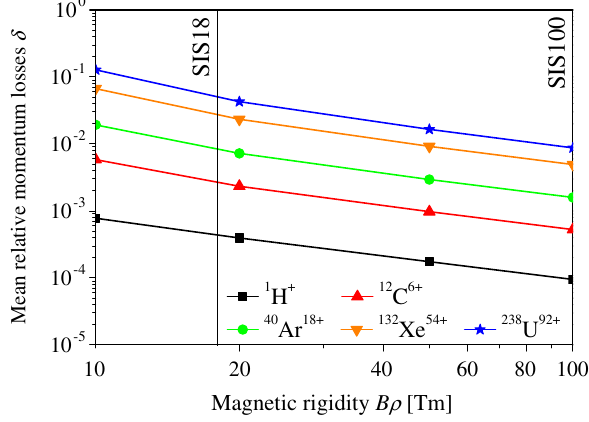
FIG. 2. Mean relative momentum losses in 1 mm thick primary collimator made of tungsten calculated by using FLUKA .